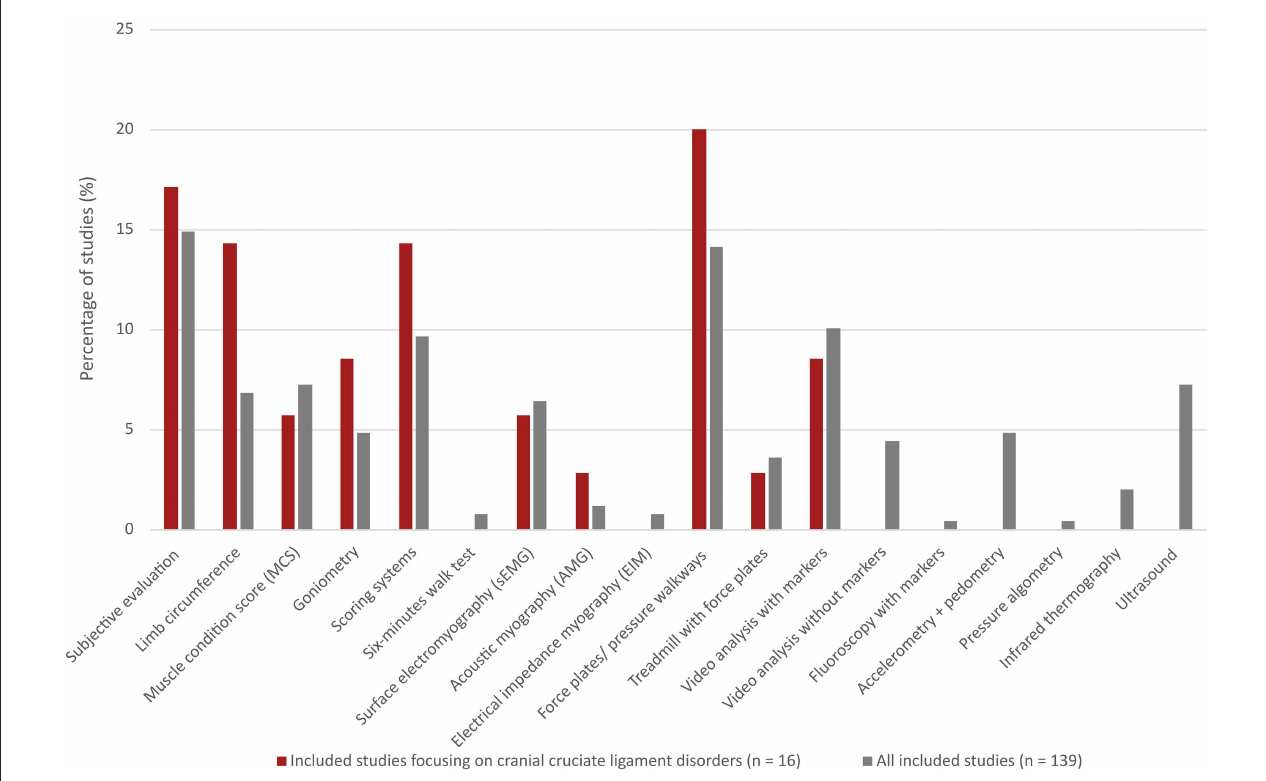
FIGURE3 Percentage distribution of 18 different muscle function assessment methods among all the included studies ( n = 139, grey bars) compared with the distribution in only a small part of these studies focusing on cranial cruciate ligament disease ( n = 16, red